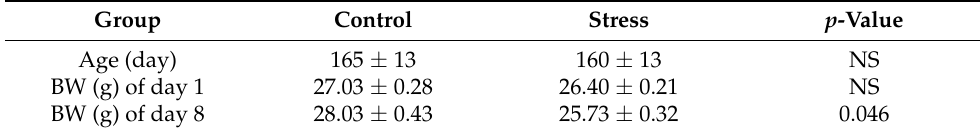
Table 2. Summary of the general information of control and stressed mice. Group Control Stress p -Value Age (day) 165 ±